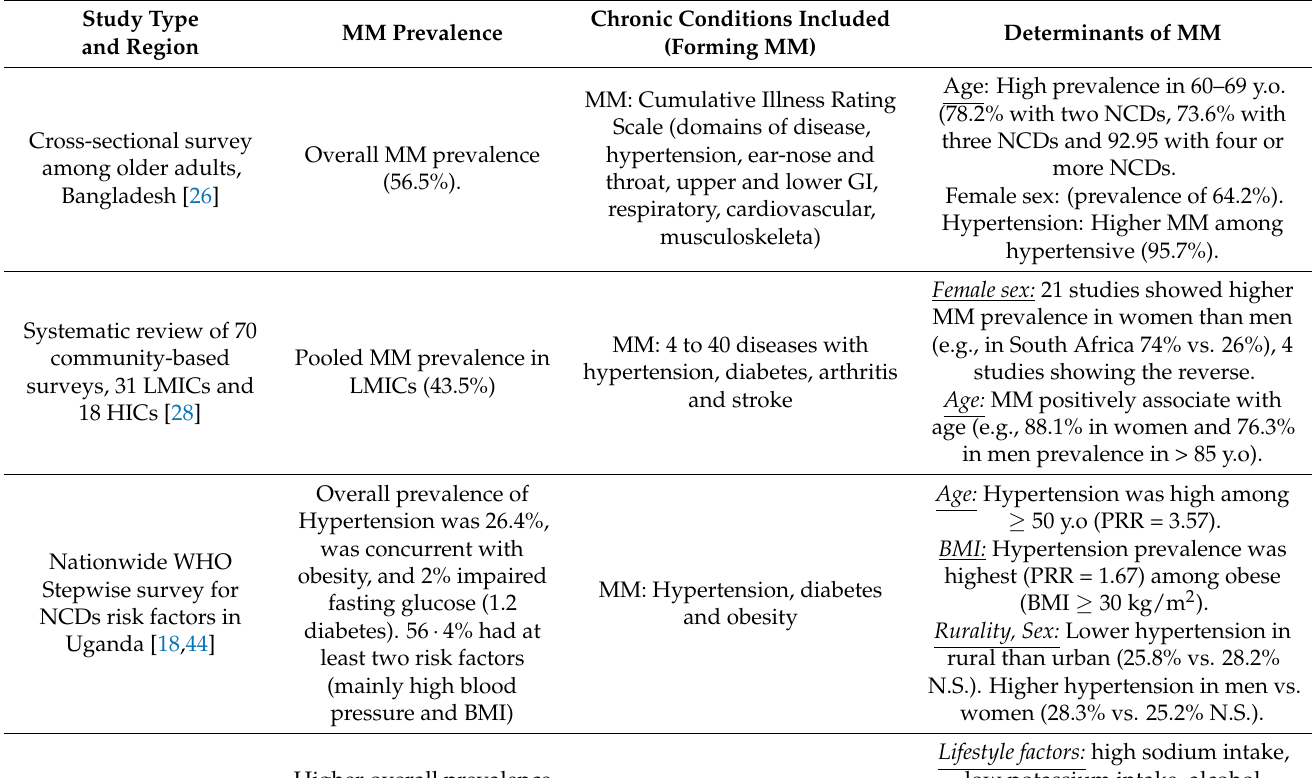
Table 1. Multimorbidity (MM) determinants across low and middle-income countries